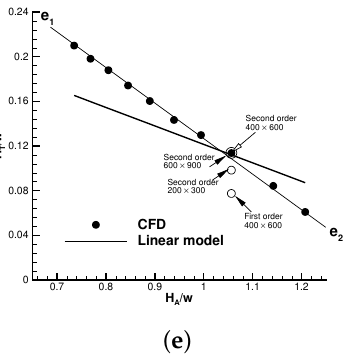
Figure 8. Comparison between the linear model (25) and CFD data: ( a ) H T versus g for M 0 = H A H A 4, θ w = 25 ◦ ; ( b ) H T versus g for M 0 = 4, θ w = 25 ◦ ; ( c ) H T versus g for M 0 = 4, θ w = 30 ◦ ; ( d ) H T w w H A H A H A versus g for M 0 = 3, θ w = 25 ◦ ; and ( e ) H T versus H A for M 0 = 4, θ w = 25 ◦ w w H A